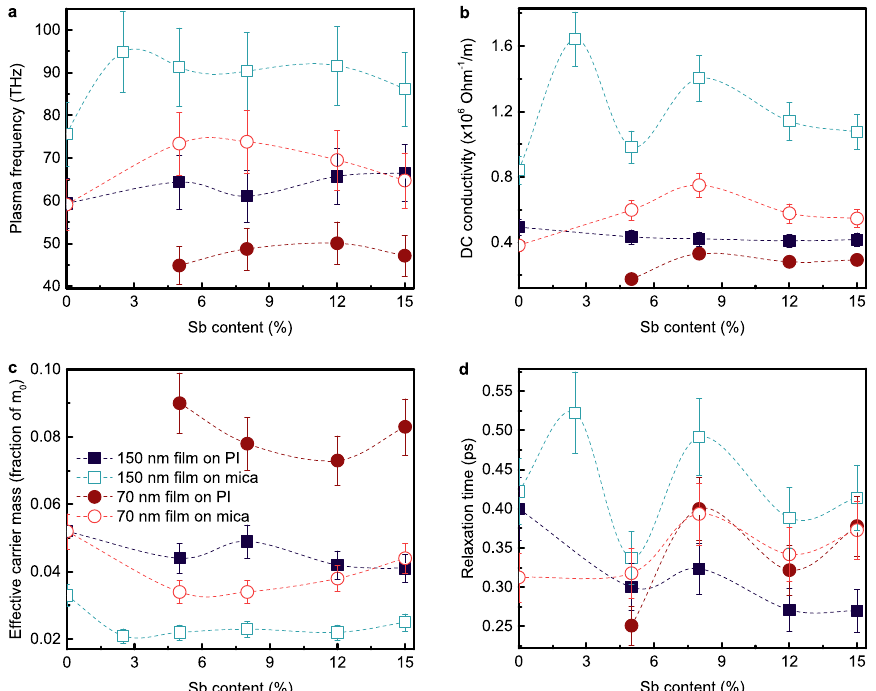
Figure 6. Parameters extracted using Drude model for conductivity/permittivity in cases of various Sb concentrations: plasma frequency ( a ) and relaxation time ( d ), DC conductivity ( b ) and effective carrier masses ( c ) in fraction of m 0 . The points for 0 % antimony concentration (pure bismuth) and for 150 nm Bi 97.5 Sb 2.5 (on mica substrate) are added based on another THz measurements of thin Bi films with various thicknesses.